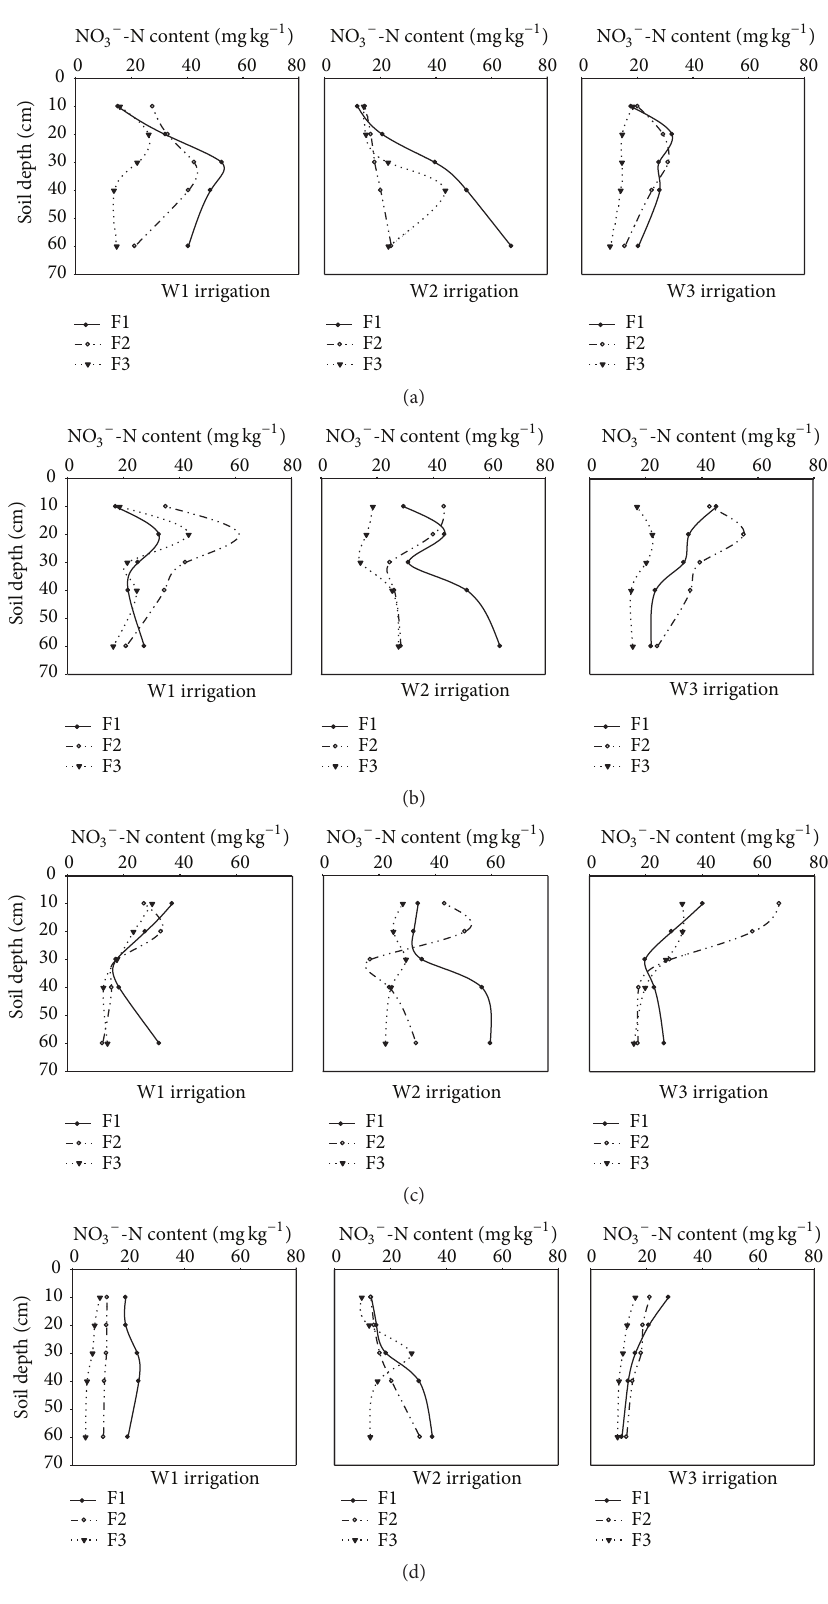
Figure 1: The effects of different irrigation and fertilization on soil NO 3− -N content were varied by soil depth in 2012: (a) 25 days after transplanting,(b)43daysaftertransplanting,(c)59daysaftertransplanting,and(d)117daysaftertransplanting.W1:100% ET 0 :W2:75% ET 0 , and W3: 50% ET 0 ; F1: N240–P 2 O 5 120–K 2 O150kg hm −2 ; F2: N180–P 2 O 5 90–K 2 O112.5 kg hm −2 ; and F3: N120–P 2 O 5 60–K 2 O75 kg hm −2